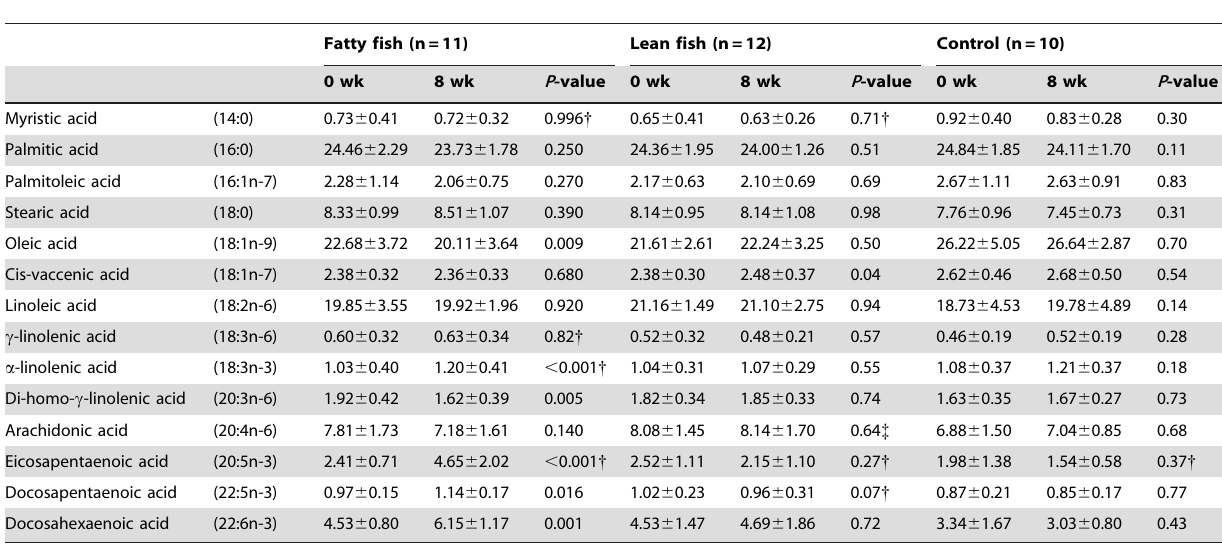
Table 3. Plasma fatty acids (%) at baseline and after the 8-week intervention (mean 6 SD).